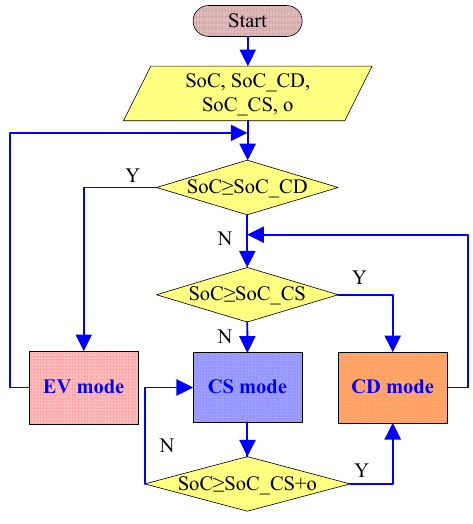
Figure 6. Mode switching control strategy.